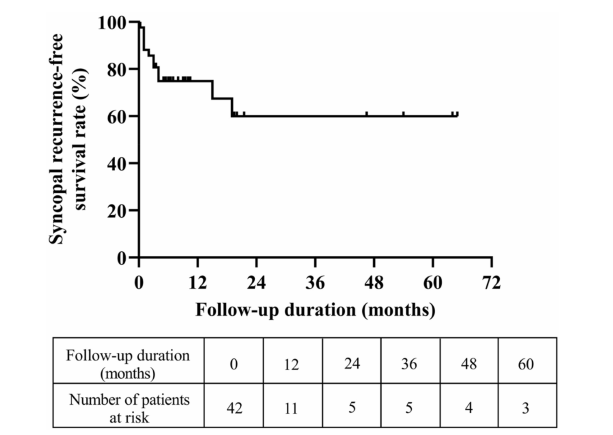
FIGURE 1 | Number of patients with different syncopal episodes before treatment. The y -axis represents the number of patients; the x -axis represents the number of previous syncopal episodes before treatment. The median frequency was 4.0 episodes/person/year.